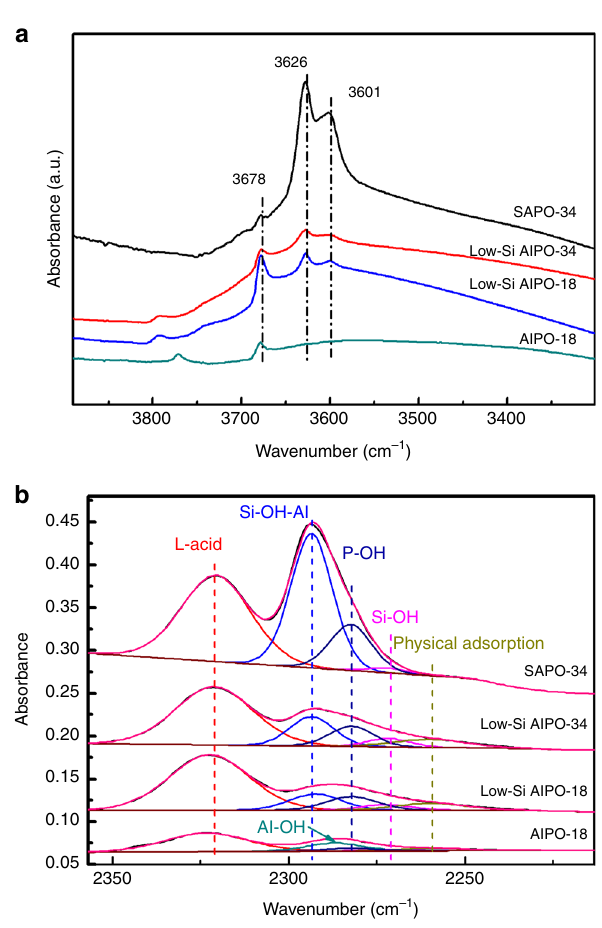
Fig. 4 FTIR spectra. a FTIR spectra of calcined low-Si AlPO-18, low-Si AlPO- 34, and SAPO-34 zeolites after vacuum dehydration at 400 °C. b Fitted FTIR spectra of CD 3 CN adsorption over calcined AlPO-18, low-Si AlPO-18, low-Si AlPO-34, and SAPO-34 zeolites at room